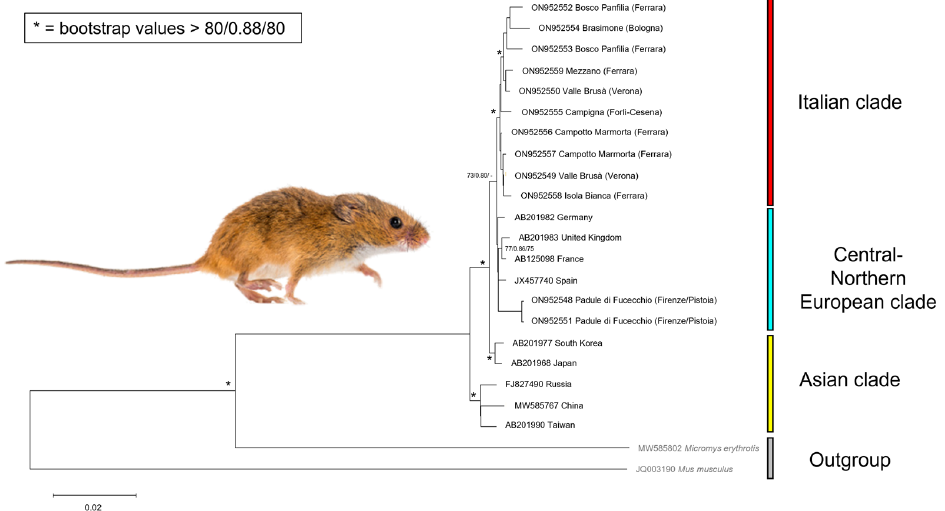
Figure 2. ML tree obtained from the analysis of cytb for 1150 positions. For each node, support values (NJ Bootstrap support/Bayesian probabilities/ML Bootstrap support) above 80/0.88/80 were shown as asterisks. We used Micromys erythrotis and Mus musculus as outgroups. In the phylogeographic network, two haplogroups could be identified: (A) including all Italian sequences, except for Padule di Fucecchio samples; (B) including all the other Eurasian samples (Figure 3).